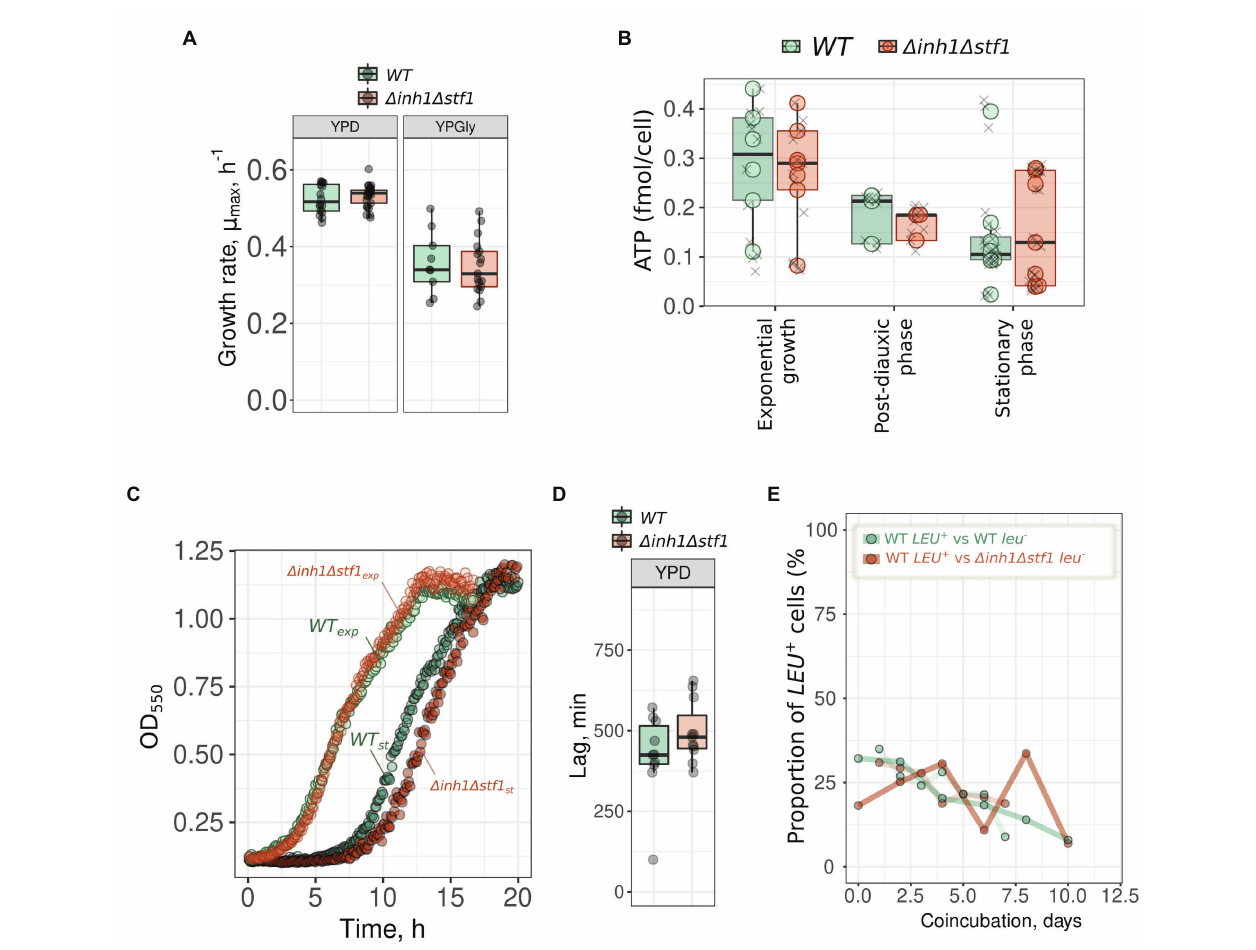
FIGURE 4 | Double deletion of INH1 and STF1 has no effect on yeast cells fitness. (A) Growth rates ( μ max ) of the control HIS + TRP + ( WT ) and Δ inh1 Δ stf1 strains in rich medium supplemented with glucose (YPD) or glycerol (YPGly); (B) ATP concentration in the control HIS + TRP + (WT) and Δ inh1 Δ stf1 exponential, post-diauxic and stationary phases. Each circle data point represents an average of three ATP level measurements (individual values marked by grey crosses) in a separate day experiment. (C) Representative growth curves of yeast cells inoculated from the exponential (WT exp and Δ inh1 Δ stf1 exp ) or 10-days stationary phase (WT st and Δ inh1 Δ stf1 st ) into fresh YPD medium and (D) Quantification of the lag periods (in minutes) measured as time from the inoculation to the moment when yeast culture reached maximum growth rate. (E) Relative fitness of Δ inh1 Δ stf1 yeast cells in a competitive assay experiment. The proportion of LEU + cells in the suspension was calculated from CFU numbers after plating suspensions on selective mediums (see the section Materials and Methods, n =